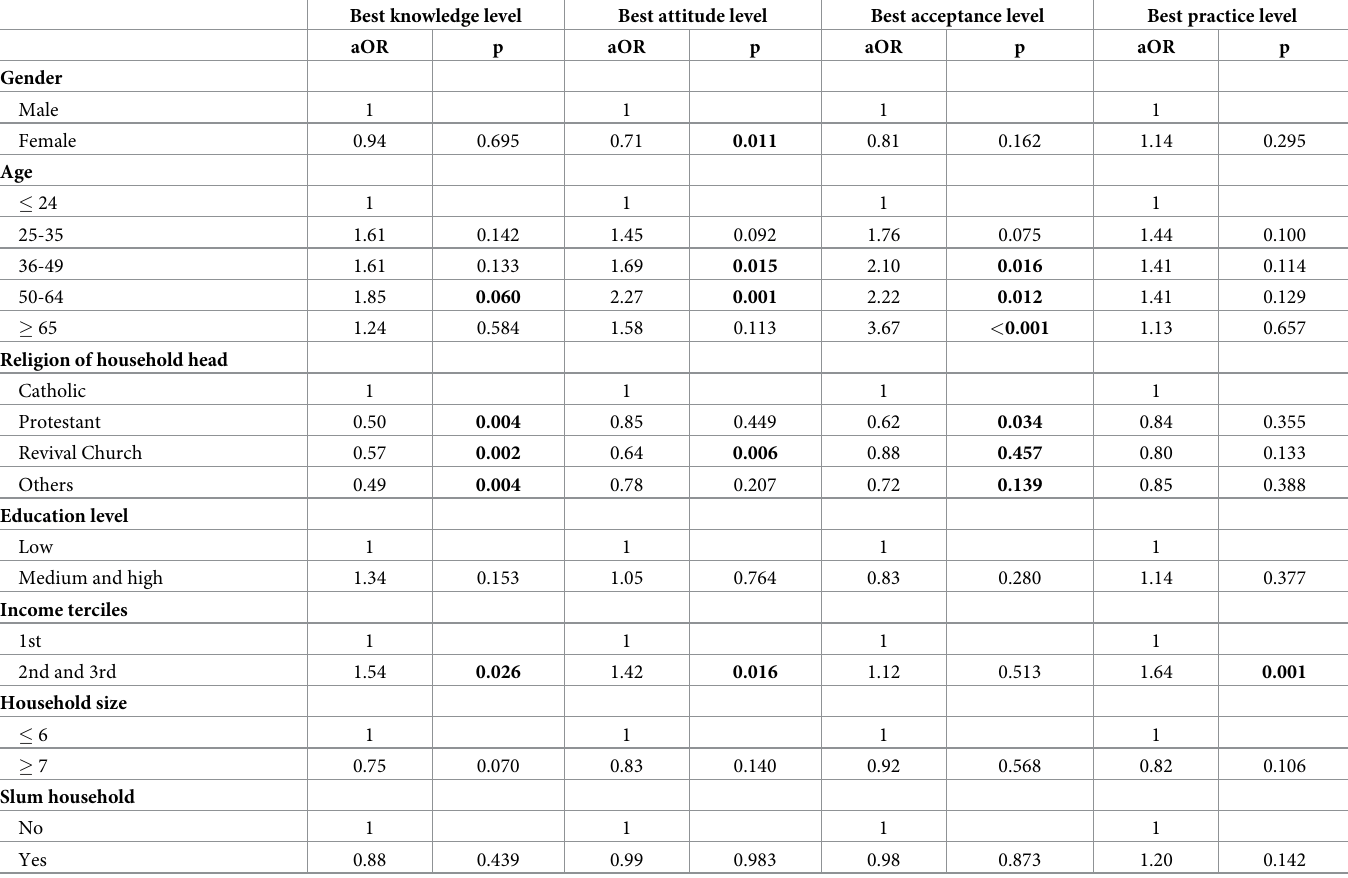
Table 3. Regression analysis of best COVID-19 knowledge and best attitude, acceptance, and practice levels toward COVID-19 prevention